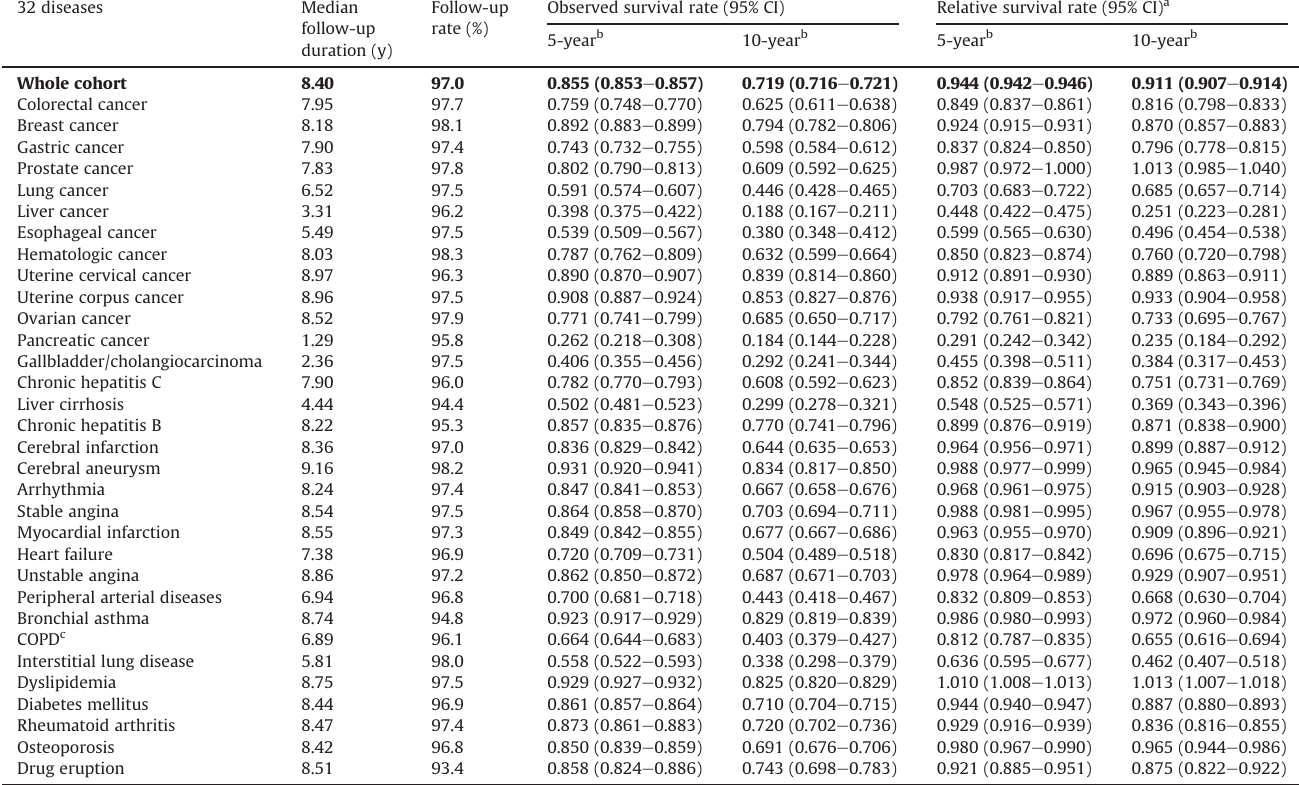
Table 2 Follow-up characteristics of subjects with any one of 32 diseases. 32